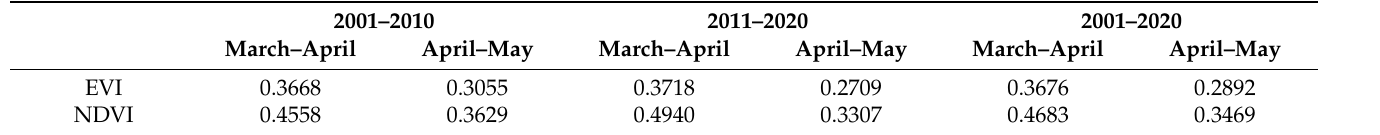
Table 1. Threshold ranges of NDVI and EVI of swidden agriculture during the dry seasons